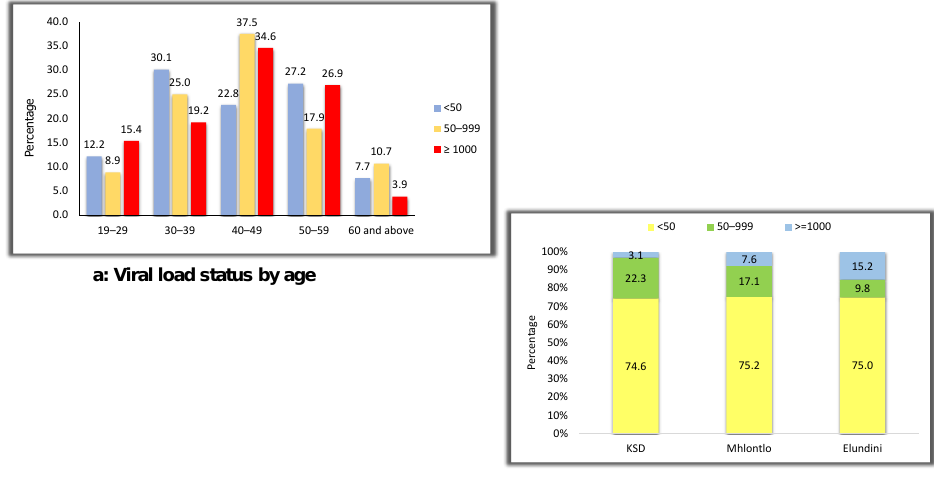
Figure 4. ( a , b ): Viral load status by age and study